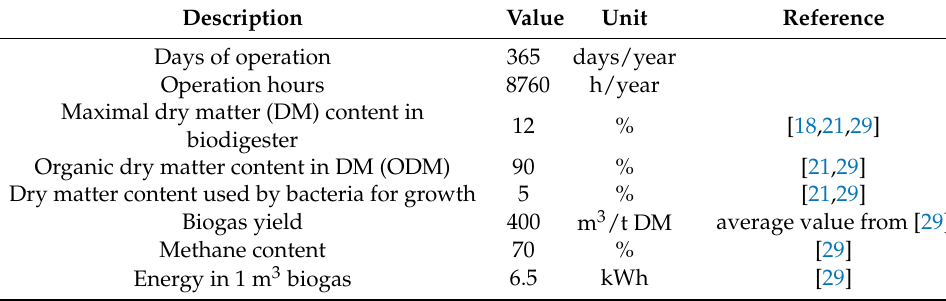
Table 3. The biogas production facility